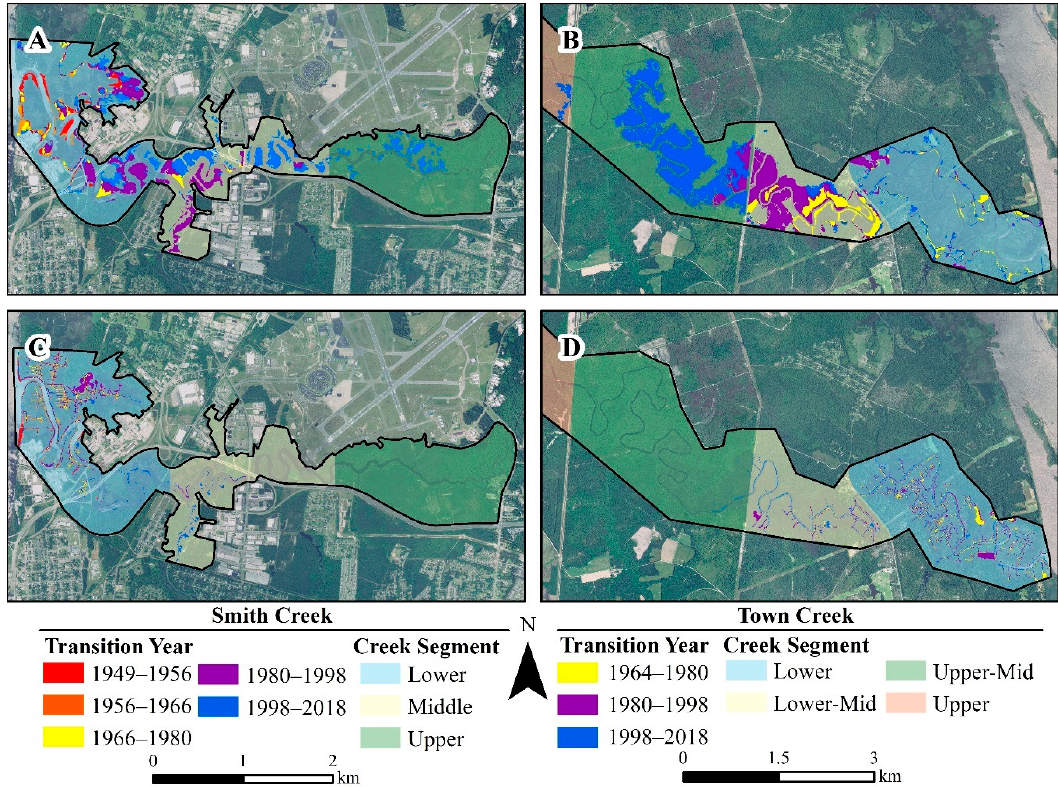
Figure 6. Land cover transitions from forest to emergent wetland ( A and B ) and emergent wetland to water ( C and D ) for Smith Creek ( A and C ) and Town Creek ( B and D ).